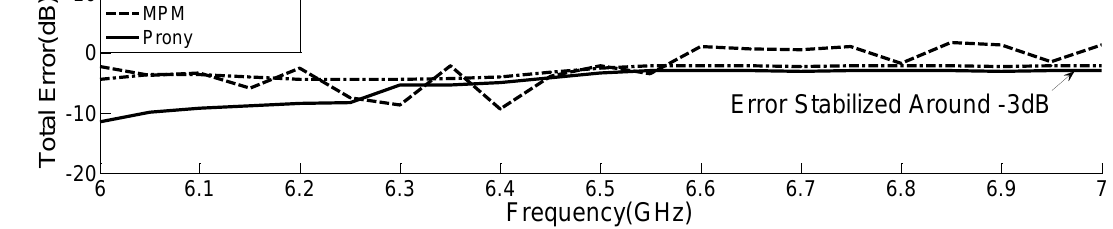
Figure 9. Jet Plane Prediction error results in all directions.